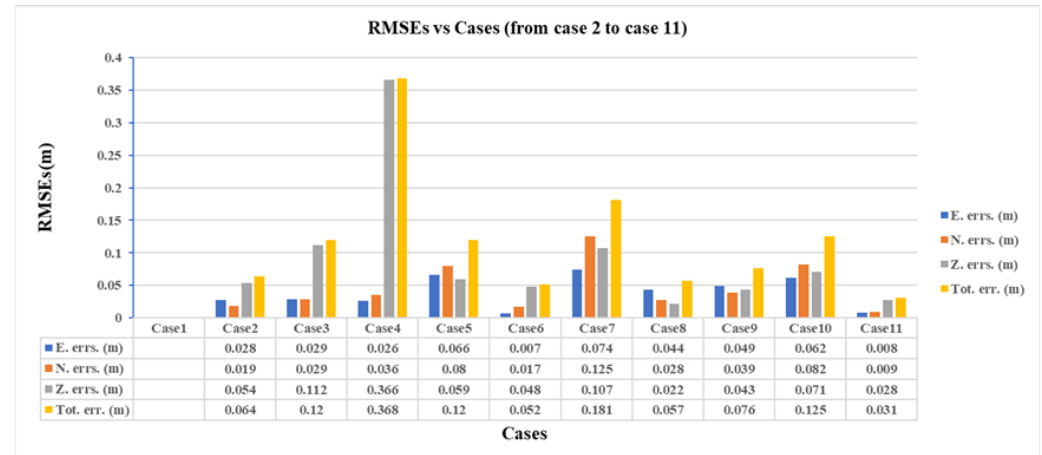
Figure 8. The RMSEs for the last ten cases.